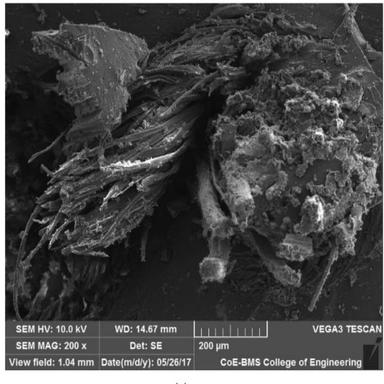
(a)–(e) SEM images of the fractured specimens.